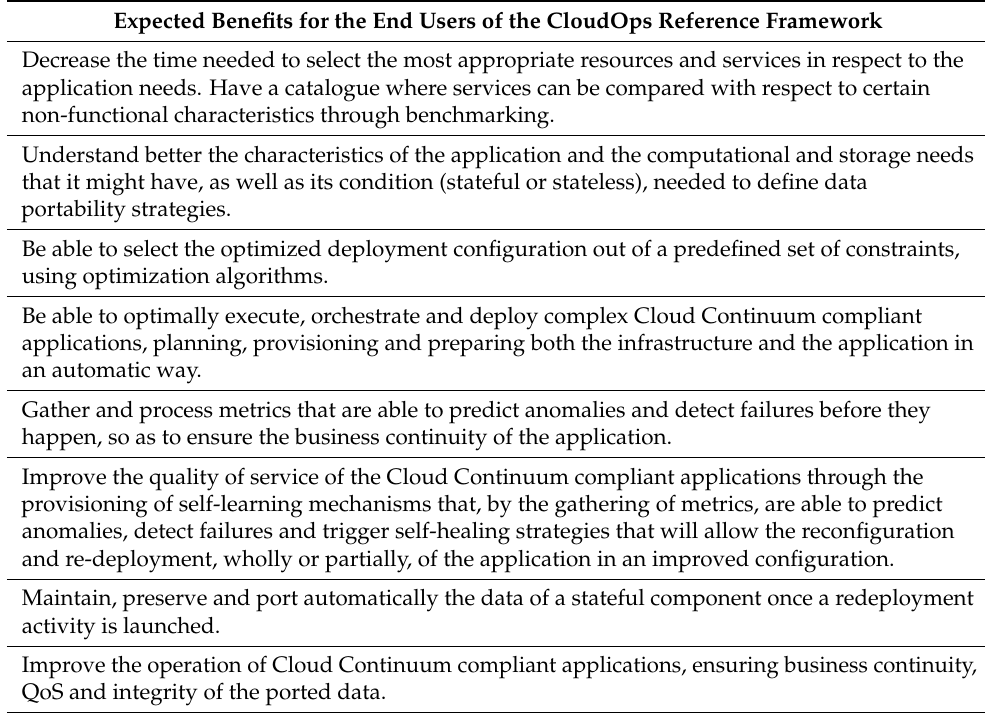
Table 2. Expected benefits for the end users of the CloudOps reference framework.